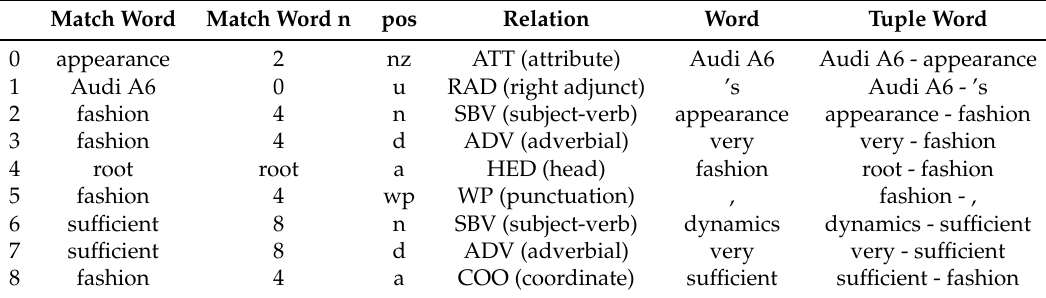
Table 3. An example of dependency parsing.